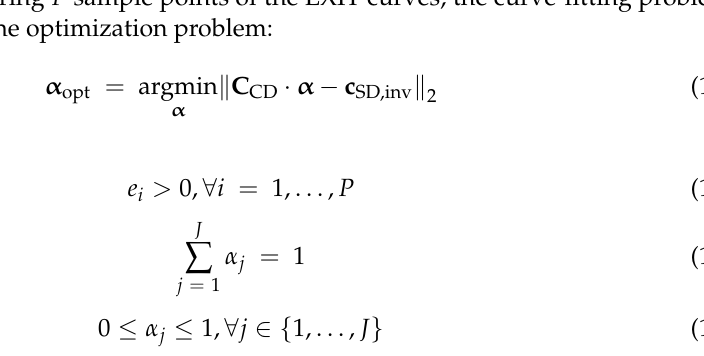
Figure 4. EXIT curves of different RNSC codes, AWGN channel, SNR = 8 dB, 16QAM Gray mapping. J Then, the EXIT curves of encoders should satisfy = α of the different RNSC subcodes. The over- () 1 , 2 , J